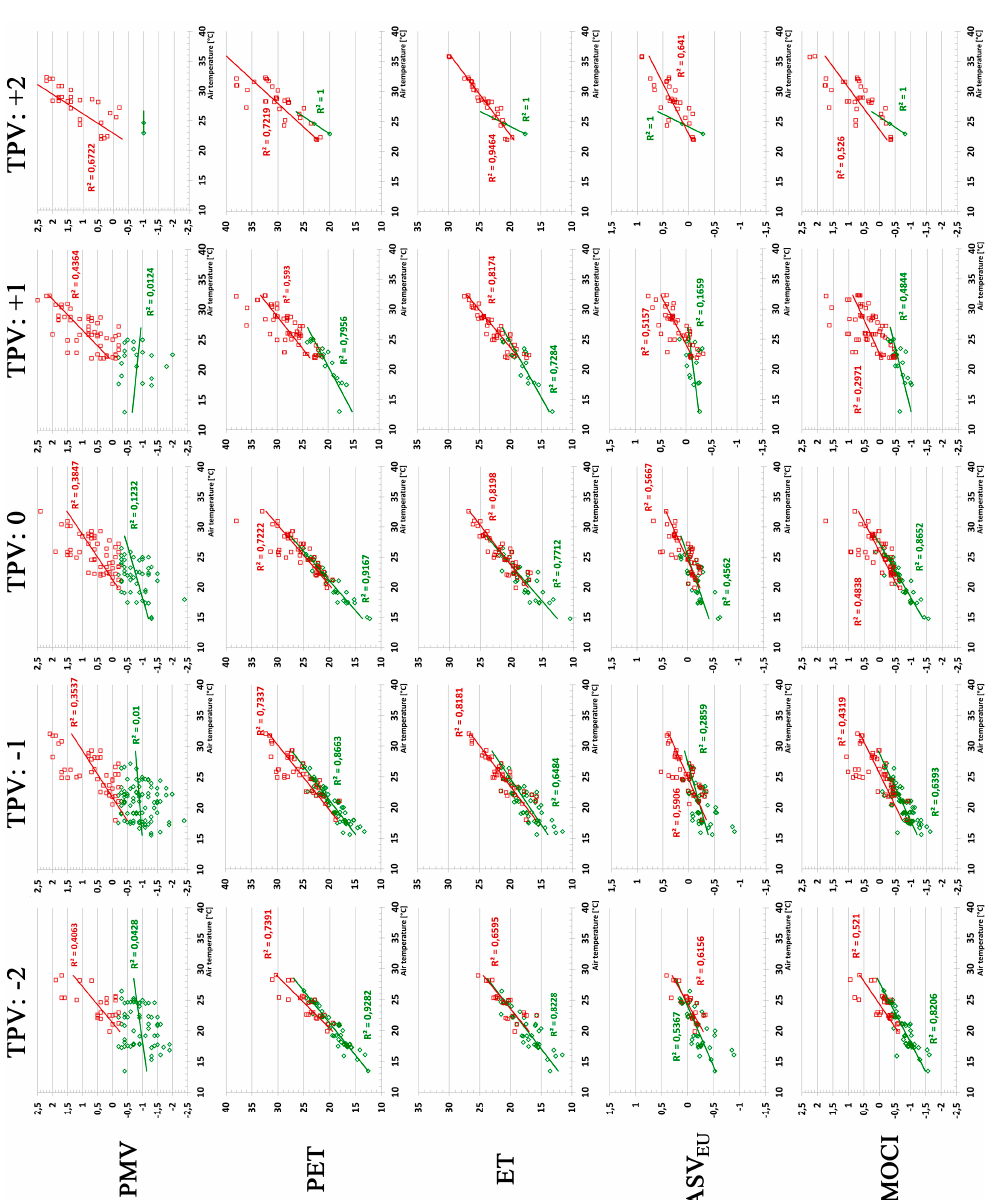
Figure 4. Seasonal dependence of the indices in function of the air temperature for the classes of thermal perception votes ( − 2), ( − 1), (0), (+1) and (+2). An index used to evaluate outdoor thermal comfort should be able to describe the thermal perception of a human being in any climatic condition. Hence the indices should present a certain stability. With reference to Table 2, this means that if there is a thermal perception vote of − 2, the corresponding PET values should be ranging between 4 and 8 °C, the MOCI values between − 2.5 and − 1.5 and so forth for all other indices and the votes given by the interviewees.